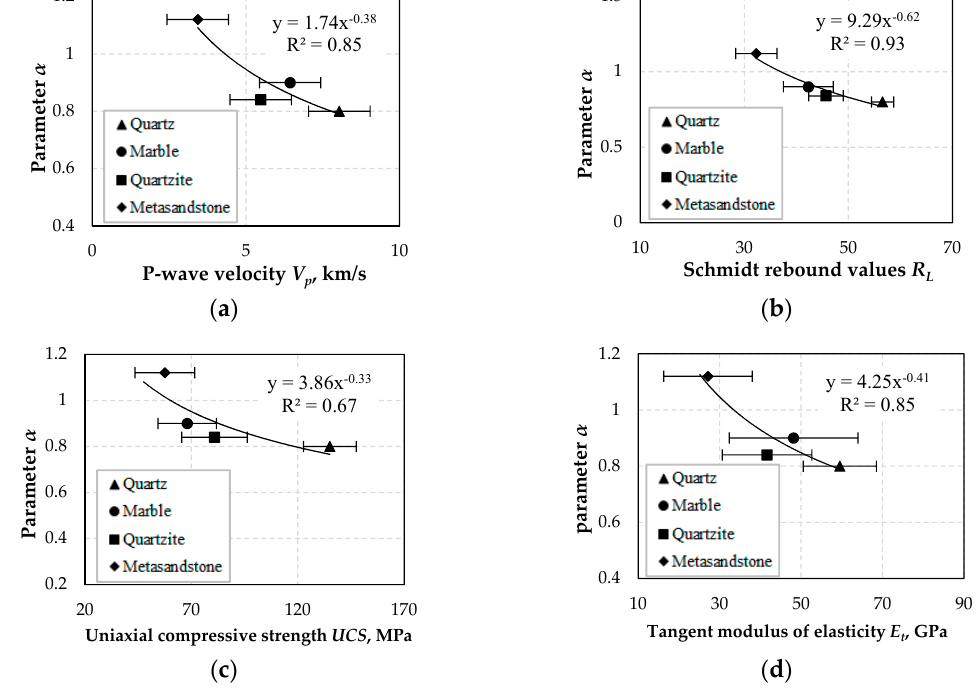
Figure 12. Correlations between parameter α and ( a ) P-wave velocity V p , ( b ) Schmidt rebound values R L , ( c ) uniaxial compressive strength UCS and ( d ) tangent modulus of elasticity E t ; horizontal error bars show standard deviation of the measurements.